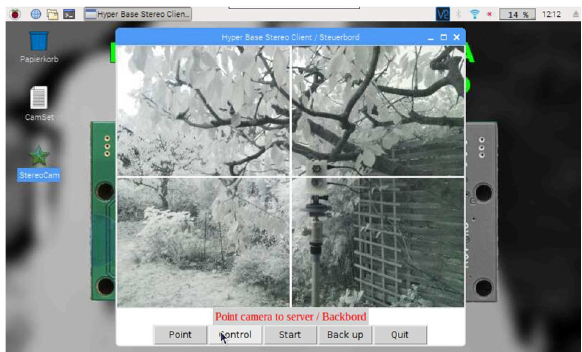
Figure 9: GUI interface for taking photographs